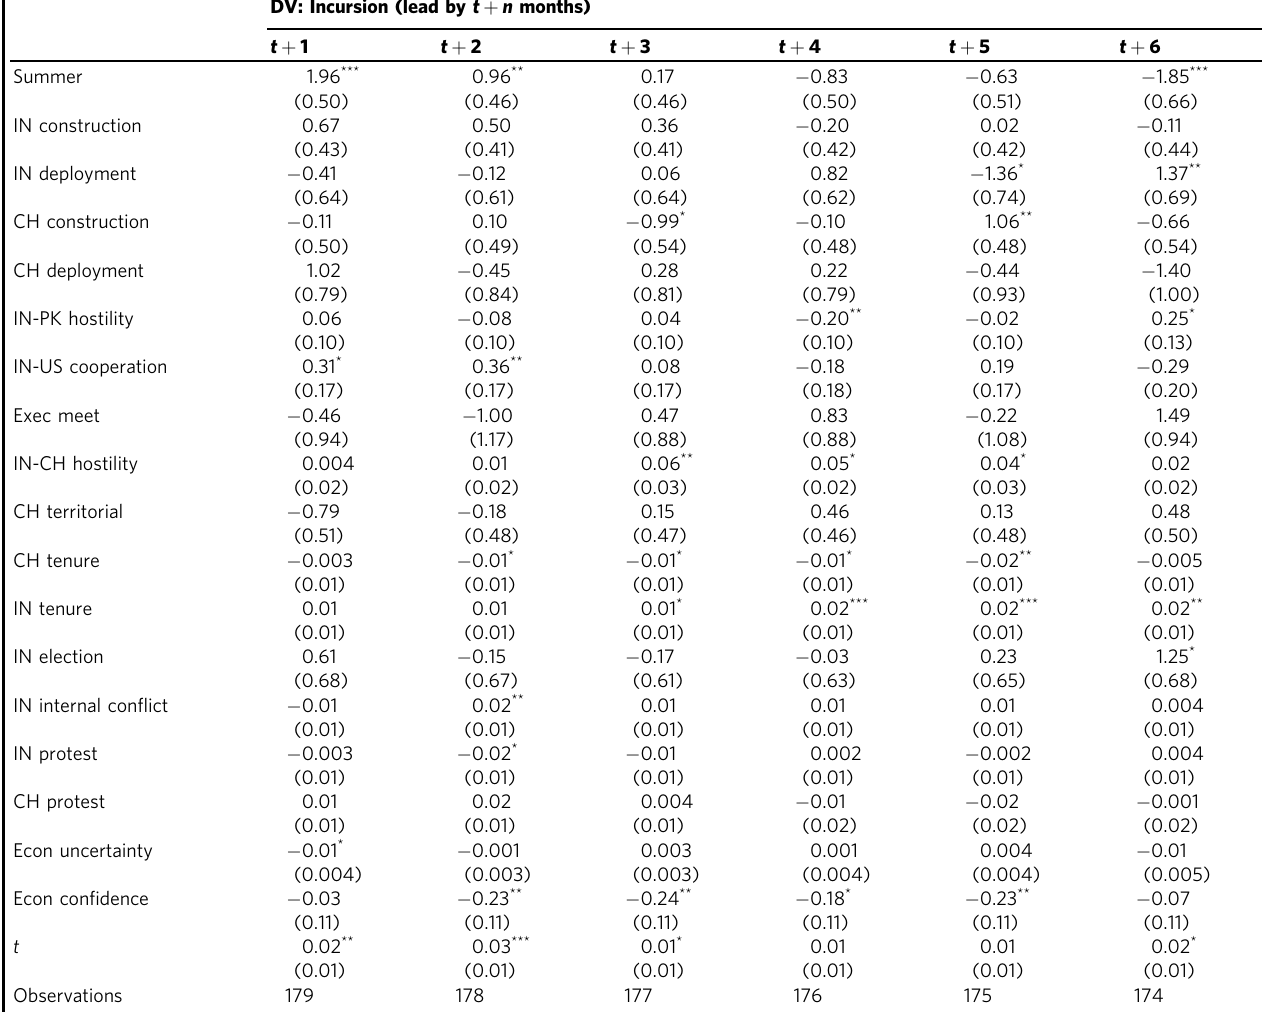
Regression coef fi cients for each variable, standard errors are shown in parentheses. Each column represents the estimates when the dependent variable is led that many months. * p <0.1; ** p <0.05; *** p